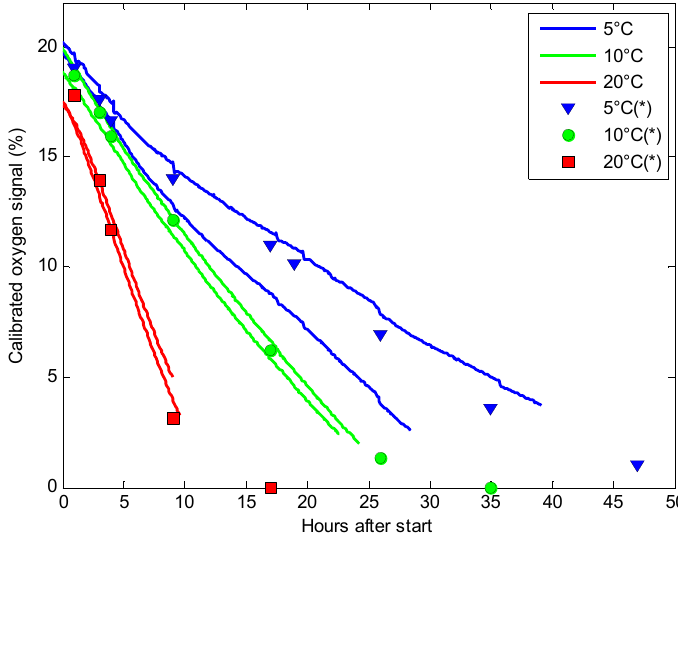
Figure 3. The calibrated oxygen signals from six sensors placed at 5 °C (blue lines), 10 °C (green lines) and 20 °C (red lines) at hours after initiating the experiment, and the corresponding discrete reference measurements made by PBI Dansensor are shown as